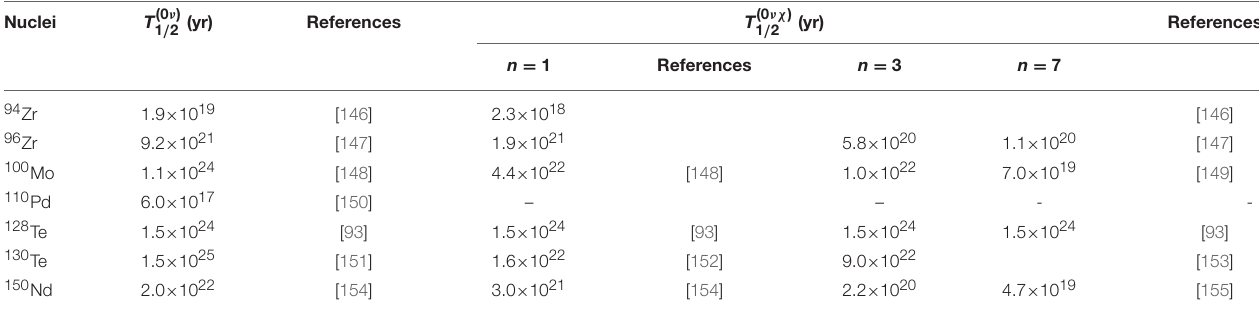
TABLE 9 | Experimentally observed half-lives T ( 0 ν) 1 / 2 ( yr ), T (0 νφ ) 1 / 2 ( yr ) and T (0 νφφ ) 1 / 2